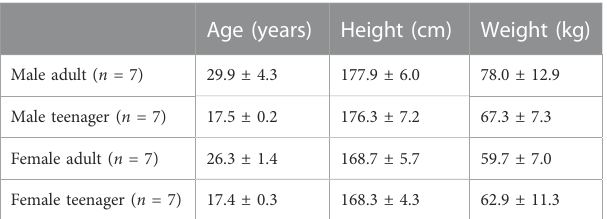
TABLE 1 Mean and standard deviation of age, height, and weight for each subject